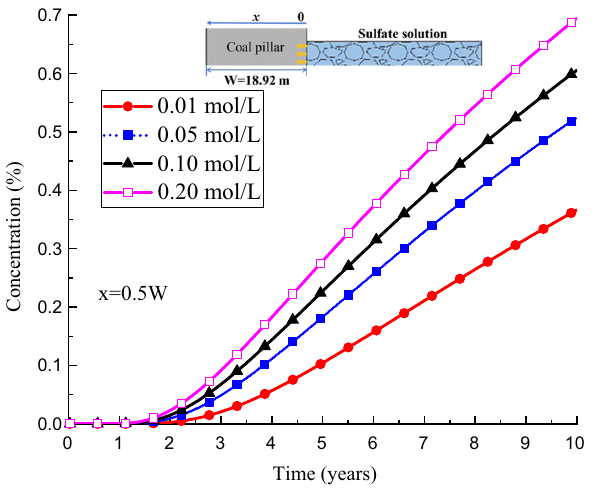
Fig. 11 Concentration distribution in the coal dam in the 5th year